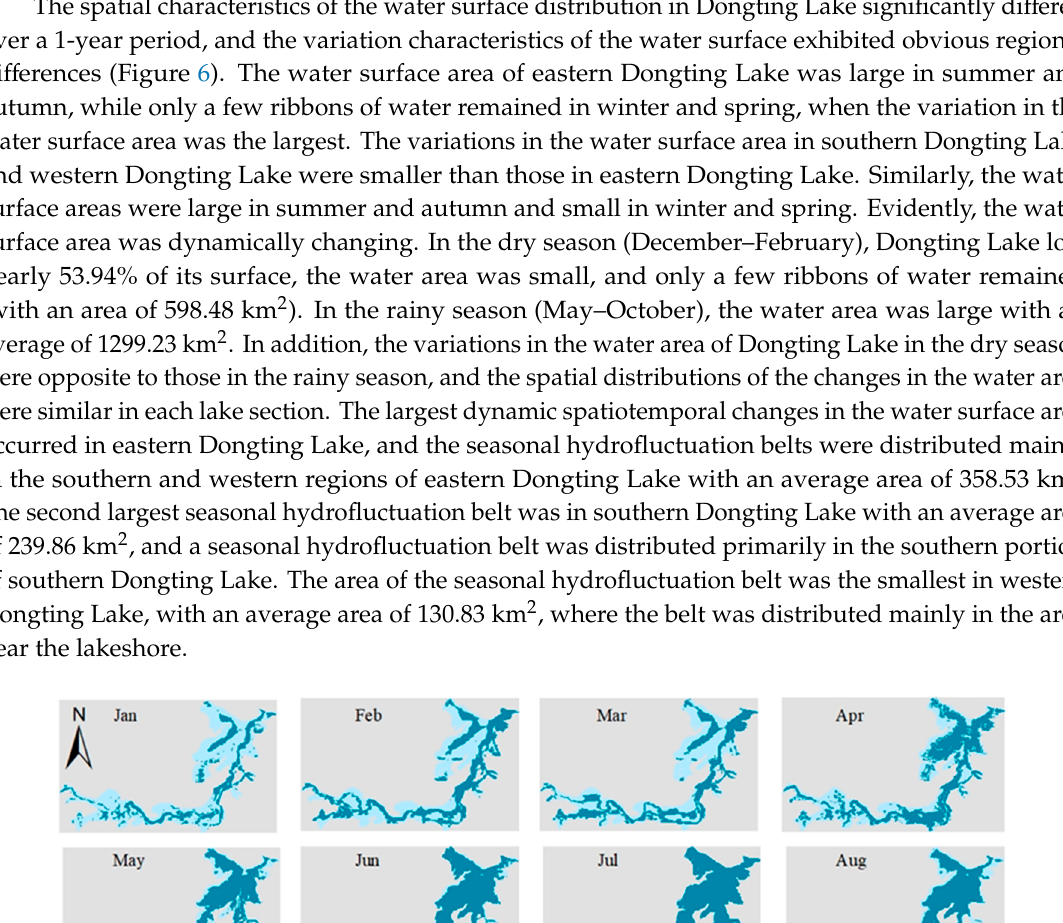
Figure 7. Spatial dynamics of interannual change trends in water surface area from the slope during 2001–2017 (k describes the rate of the frequency increasing/decreasing; a negative k indicates a decrease in the frequency (decreasing)).